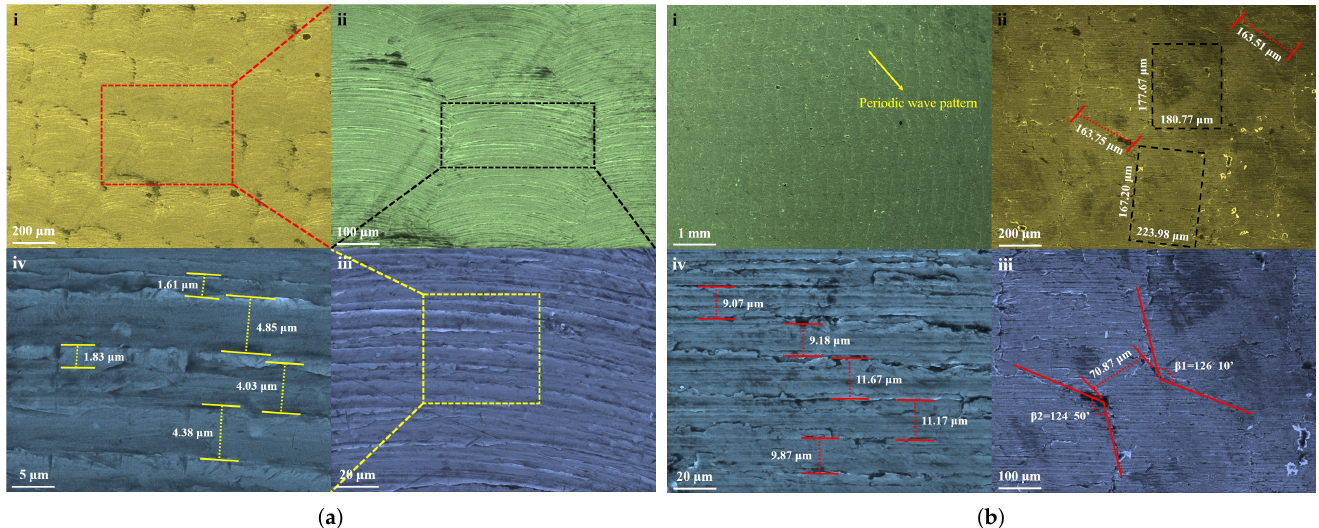
Figure 6. Microstructure observation of aluminum alloy (AA3003) material by FESEM at various magnifications at: ( a ) location 2; ( b ) location